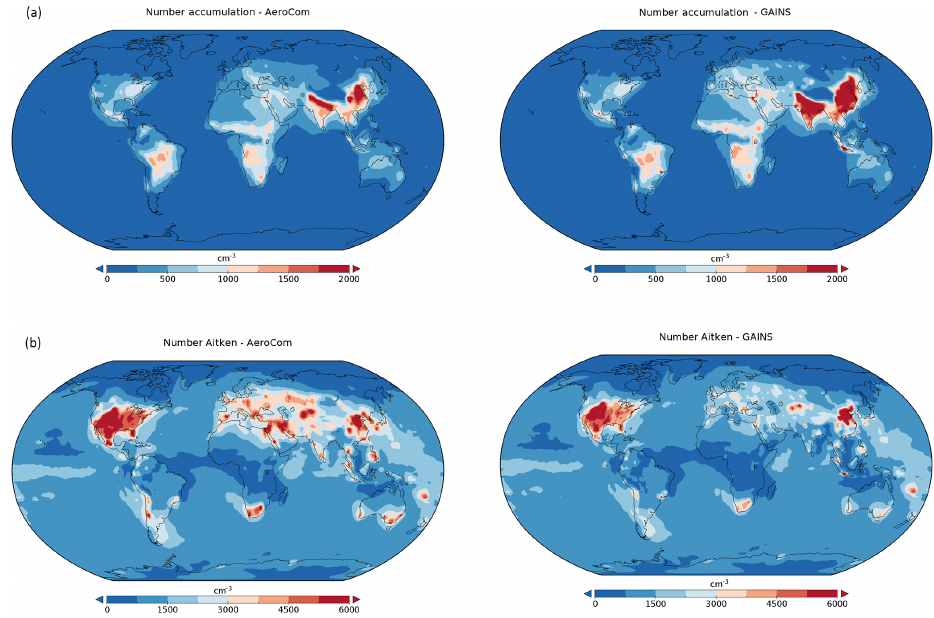
Figure 6. Modeled annual particle number concentrations for accumulation mode (a) and Aitken mode (b) at surface